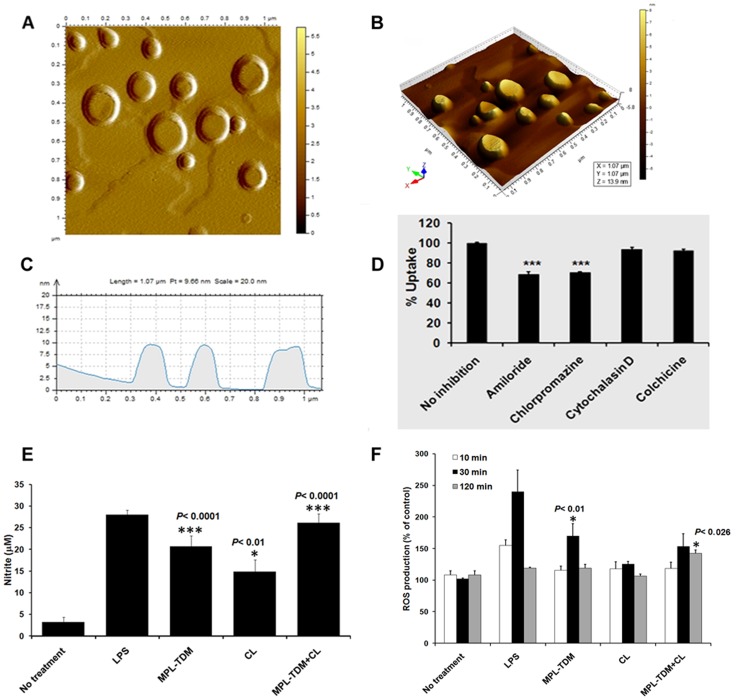
Particle characterization, cellular uptake and localization of cationic liposomes in hamster macrophages (MΦs).A–C, tapping mode AFM images of liposomes obtained 15 mins after deposition on mica support. A, AFM image presented as two-dimensional graphics showing the clean spherical shaped DSPC-liposomes. Amplitude-flattened views of liposomes are shown. B, 3D images of DSPC-liposomes by AFM study. C, horizontal cross sections indicating the height of the liposomes from the substratum, i.e., the mica sheet. D, Elucidation of cellular uptake mechanisms of cationic DSPC-liposomes in MΦs. Percent uptake of Rh-123 (green) labeled liposomes is shown in hamster peritoneal MΦs treated with or without different biochemical inhibitors, studied by flow cytometry. Data represent the mean and standard deviation of three different experiments performed in duplicate (***p<0.001, compared to no-inhibitor control). E–F, Activation of innate response towards cationic liposomes and MPL-TDM. Hamster peritoneal MΦs were isolated and stimulated with LPS (1 mg/ml), liposomes (50 mM), MPL-TDM (100 ng/ml) and combination of liposomes (50 mM) and MPL-TDM (100 ng/ml). The release of NO (E) and ROS (F) were measured subsequently. The data are representative of three independent experiments with similar results.